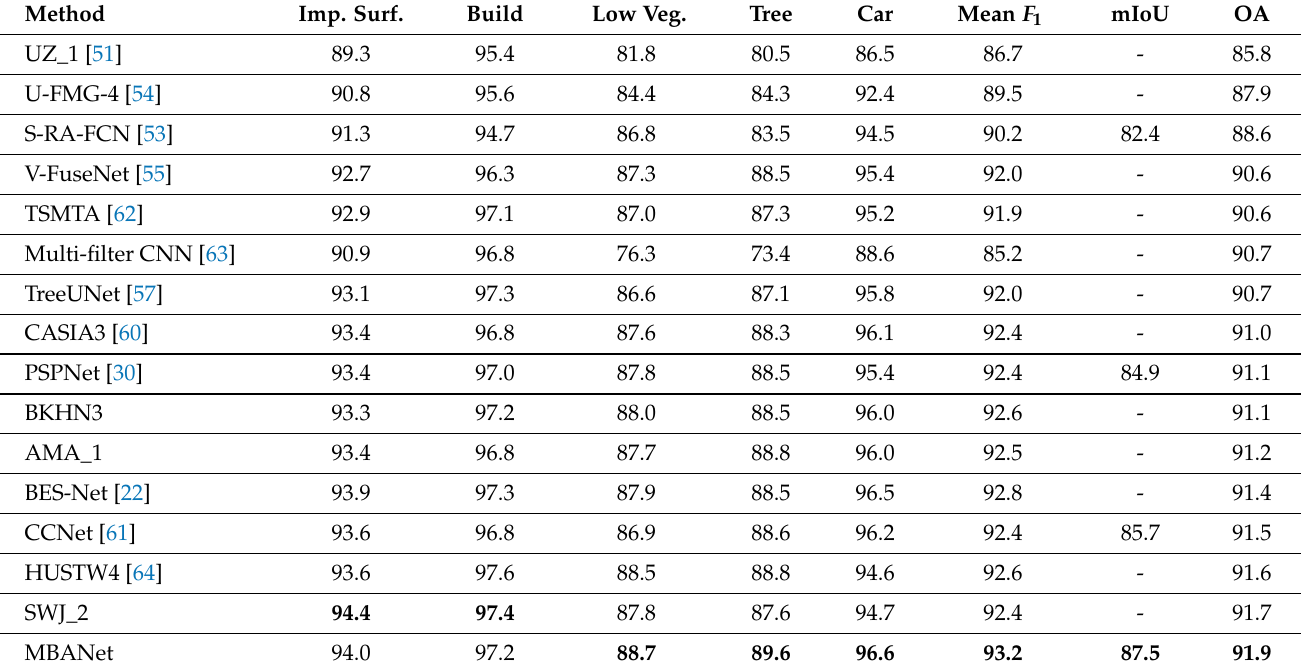
Table 13. Comparisons with SOTA methods on Potsdam